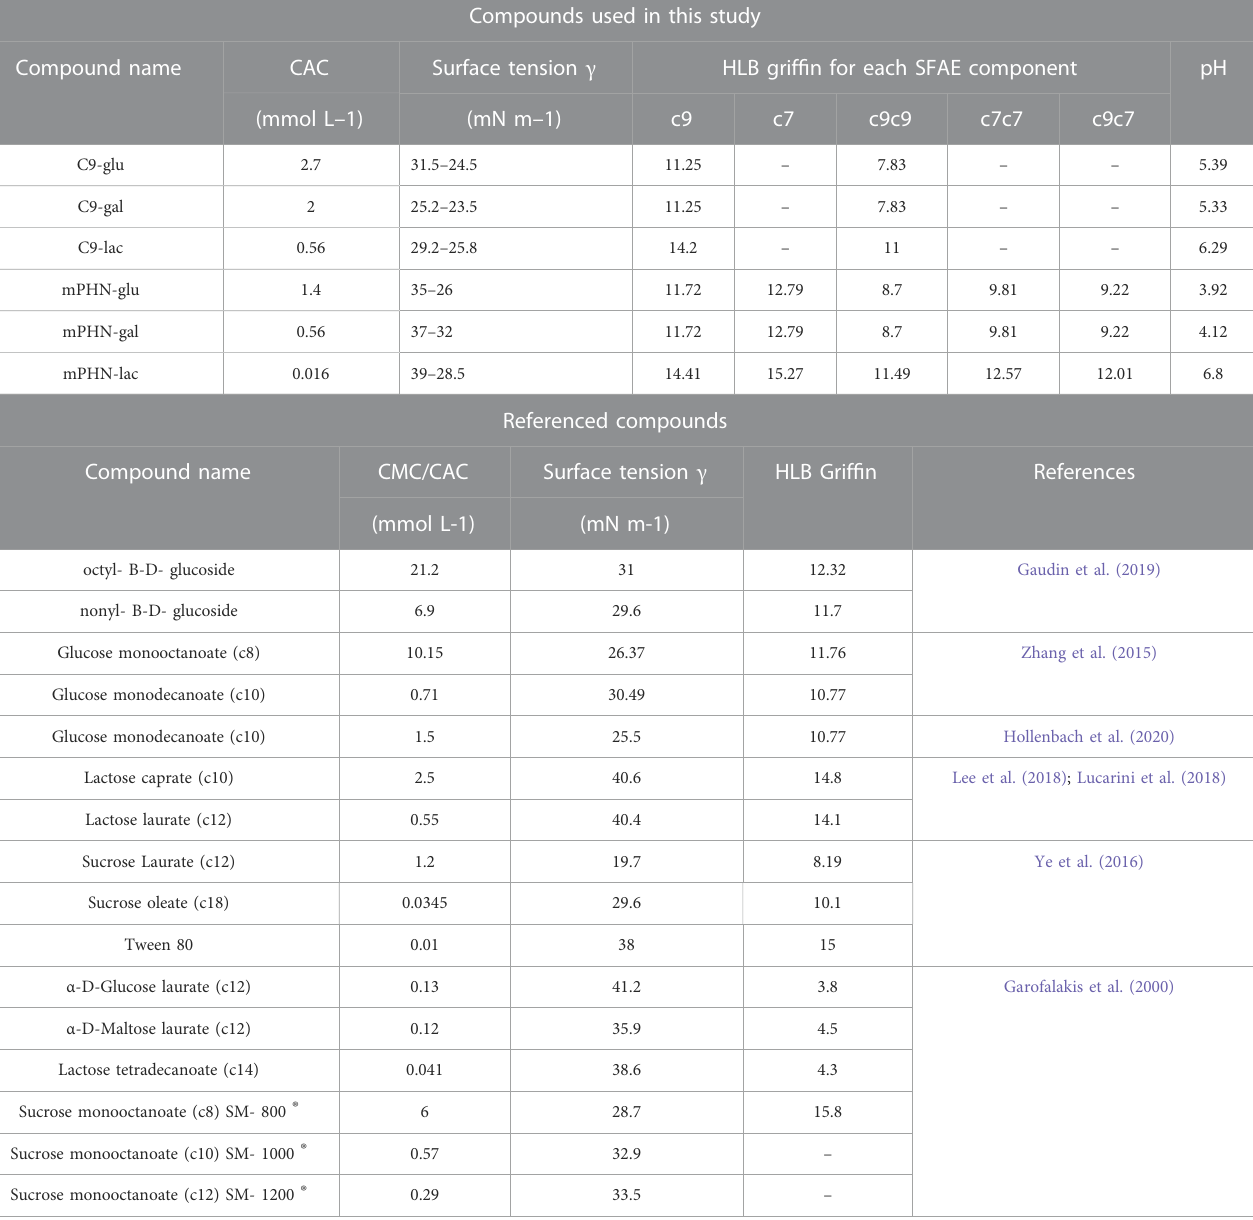
TABLE 2 Physicochemical properties of the synthetized sugar esters and reference compounds. Compounds used in this